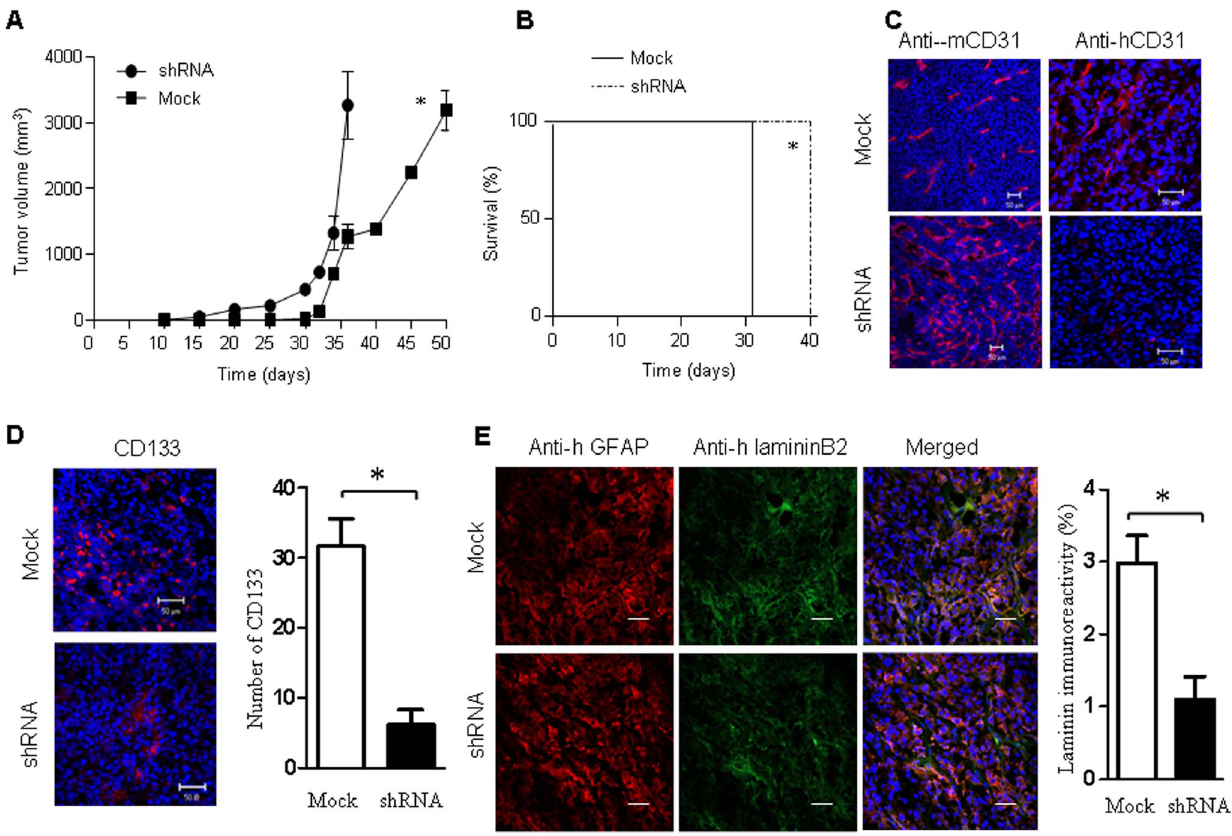
Figure 6. The effect of VEGFR-2 shRNA on tumorigenesis, angiogenesis, self-renewal and VM formation by GSLCs. ( A ) The growth of xenograft tumors initiated by GSLCs with or without VEGFR-2 shRNA. * Indicates significantly reduced growth of tumors formed by GSLCs with VEGFR-2 shRNA ( p , 0.05 ). ( B ) Survival of mice with xenograft tumors formed by GSLCs with or without VEGFR-2 shRNA. * Indicates significantly prolonged survival of mice bearing tumors formed by VEGFR-2 containing GSLCs ( p , 0.05 ). ( C ) IF images of murine or human CD31 (red) in the xenograft tumors formed by GSLCs with or without VEGFR-2 shRNA. Nuclei were stained with DAPI (blue). Scale bar=50 m m. ( D ) Self-renewal of GSLCs with VEGFR-2 shRNA. IF staining of CD133 (red) in the xenograft tumors derived from GSLCs with or without VEGFR-2 shRNA. Nuclei were stained with DAPI (blue). Scale bar=50 m m. * Indicates significantly decreased number of CD133-positive cells in mice bearing tumors formed by VEGFR-2 knock-down GSLCs ( p , 0.05 ). ( E ) VM formation by GSLCs with or without VEGFR-2 shRNA. IF staining of human LamininB2 (red) or human GFAP (green) in the xenograft tumors derived from GSLCs with or without VEGFR-2 shRNA. Nuclei were counterstained with DAPI (blue). Scale bar=20 m m. Quantitative image analysis of laminin VM immunoreactivity for glioma derived from Mock or VEGFR-2 shRNA-transfected GSLCs xenografts (n=6 recipient mice per experimental group). Y-axis, percentage of area with reactivity (mean 6 SE, * P , 0.01).